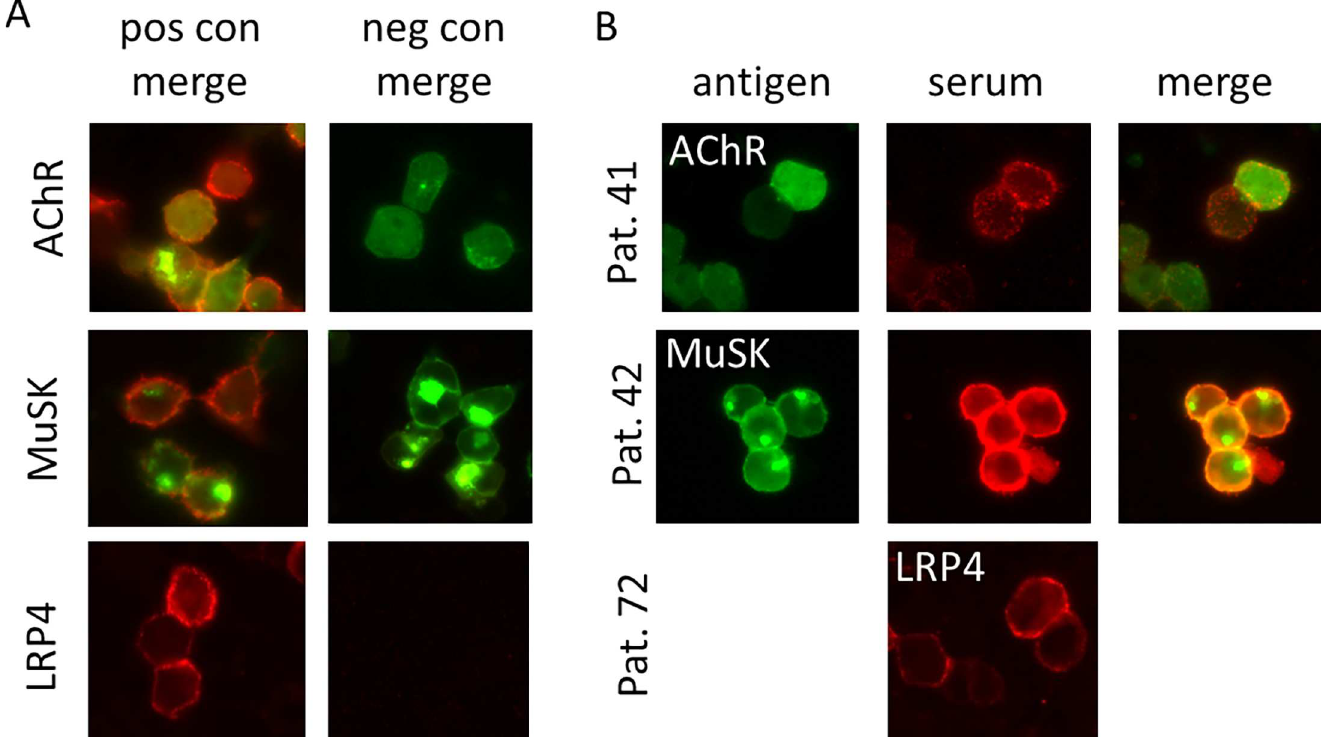
Fig 3. Cell based assays to detect antibodies to clustered AChR, MuSK or LRP4. Patient IgG binding is shown in red. For the AChR and MuSK assays, EGFP tags exhibit a green fluorescence highlighting the transfected cells; there is no color tag in the LRP4 assay. Patient 41 is positive for AChR, Patient 42 is positive for MuSK antibodies, and patient 72 is low positive for LRP4 antibodies. MuSK, muscle-specific tyrosine kinase; LRP4, low-density lipoprotein receptor-related protein 4; AChR, acetylcholine receptor.